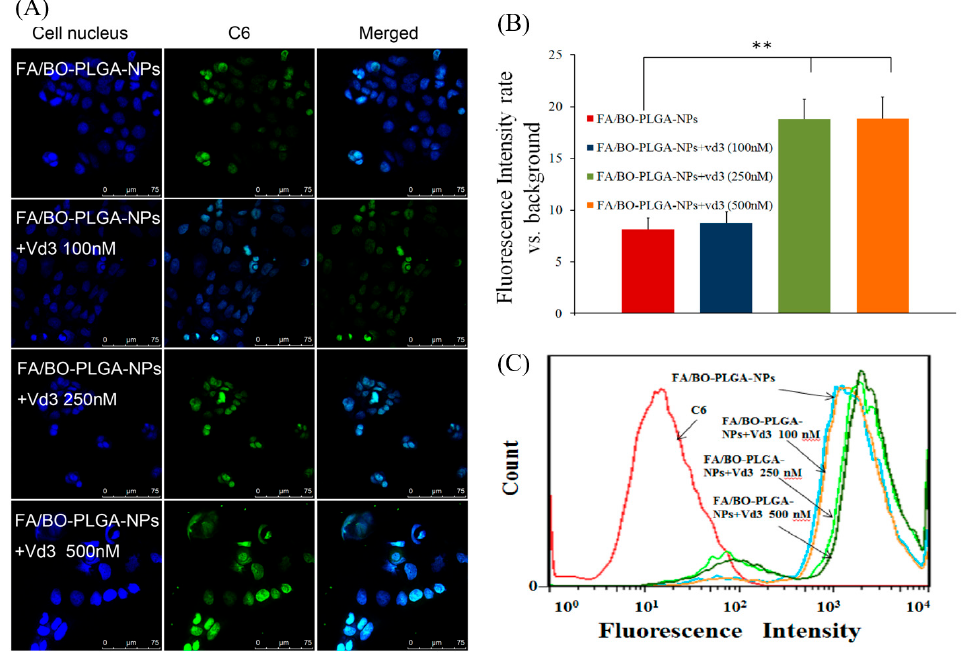
Figure 9. CLSM images ( A ) and fluorescence quantitative analysis ( B ) of Caco-2 cells after incubation with vitamin D3 (vd3) with concentrations of 0 nM, 100 nM, 250 nM and 500 nM applied to the culture cells for three days. Afterwards, we added FA/BO-PLGA-NPs to incubated cells (coumarin-6 concentration of 300 ng/mL) for 4 h. Columns from left to right correspond to DAPI, coumarin-6 and an overlay of DAPI and coumarin-6, respectively. Flow cytometry results ( C ) of Caco-2 cells incubated with vitamin D3 with concentrations of 0 nM, 100 nM, 250 nM and 500 nM applied to culture cells for three days and then treated with FA/BO-PLGA-NPs (coumarin-6 concentration of 300 ng/mL) for 4 h. * p < 0.05, ** p < 0.01.